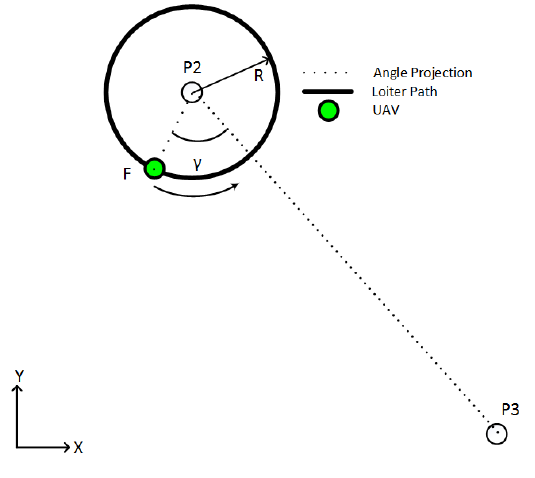
Figure 11. Angle between vehicle and POIs.